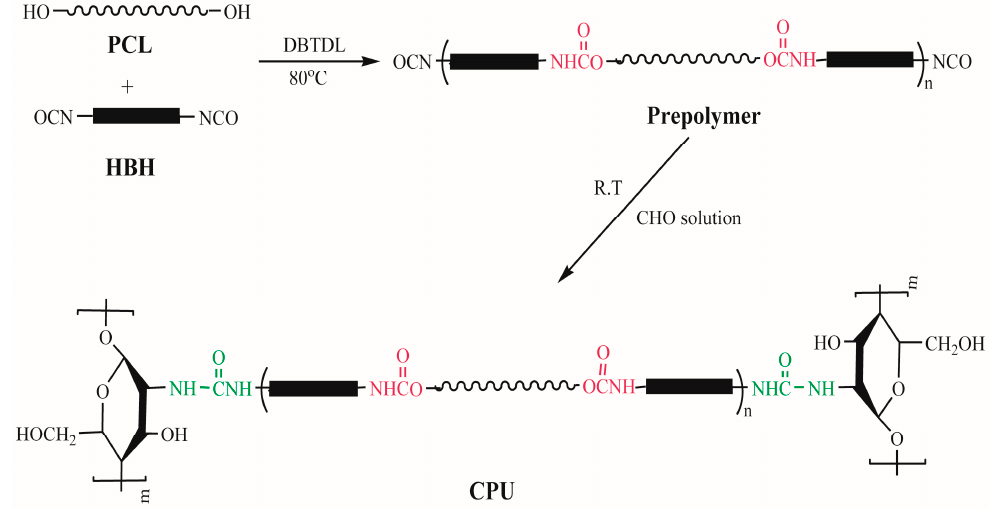
Figure 1. General reaction scheme of CPU composites.